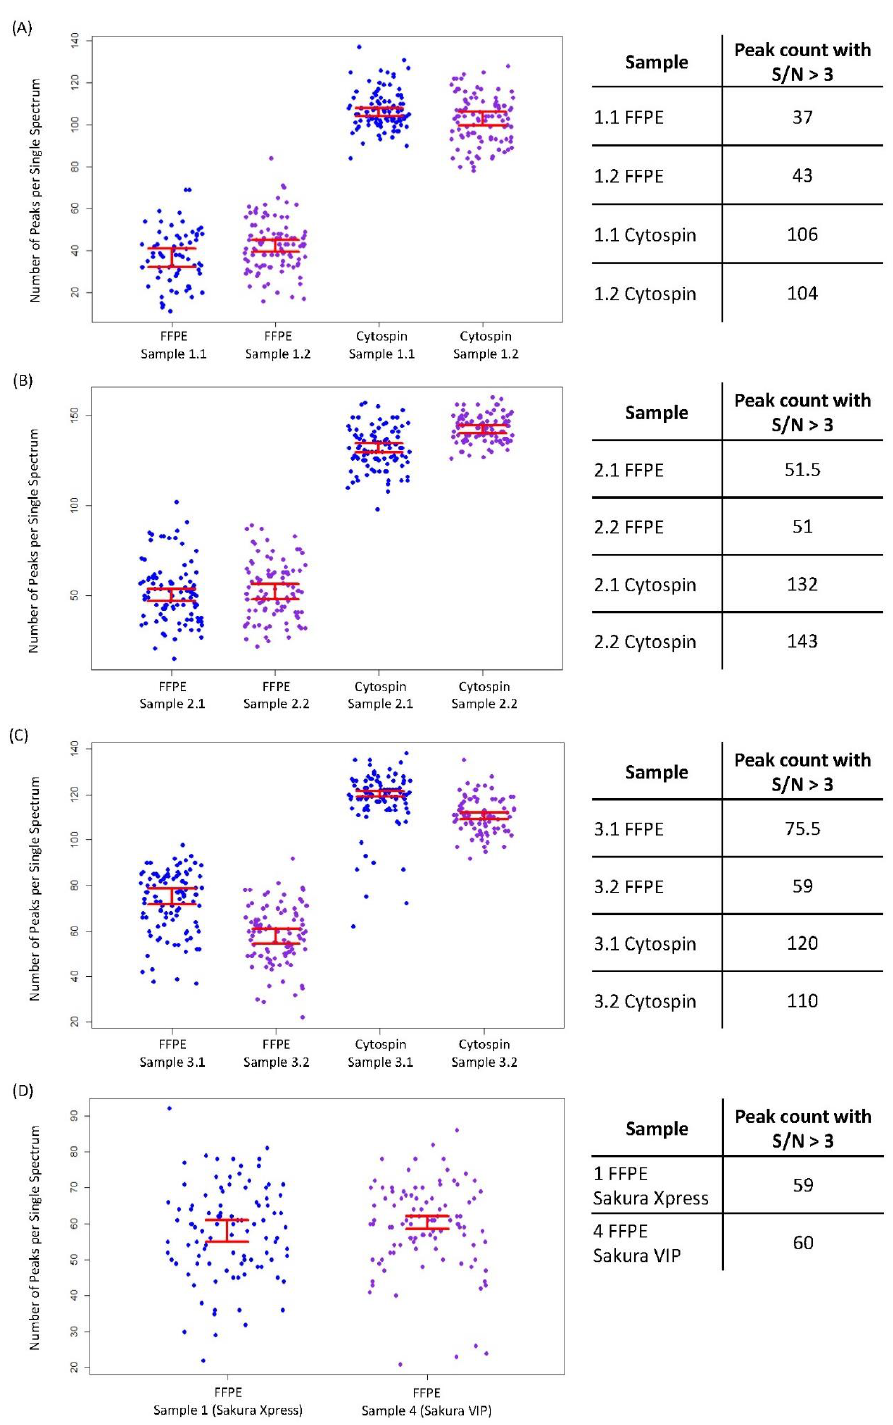
Figure 2. Comparative evaluation between FFPE and cytospin processed samples of AMO BZB (( A ), sample 1), AMO WT (( B ), sample 2), and H929 GFP/LUC (( C ), sample 3) cell lines, and between replicate specimens (1.1 and 1.2, 2.1 and 2.2, 3.1 and 3.2). From each experiment, 100 random spectra were used to calculate the number of peaks per single spectrum with signal/noise ratio (S/N) > 3 and m/z > 500 < 3000. In each cell line, more peaks were detected from the cytospin compared to the FFPE cells. A similar number of peaks and low variance were achieved in each replicate. Peak count between cells processed with the two different tissue-processing apparatuses was similar ( D ). Each pixel in the graph corresponds to the number of peaks in a single spectrum. Bars in red represent one standard